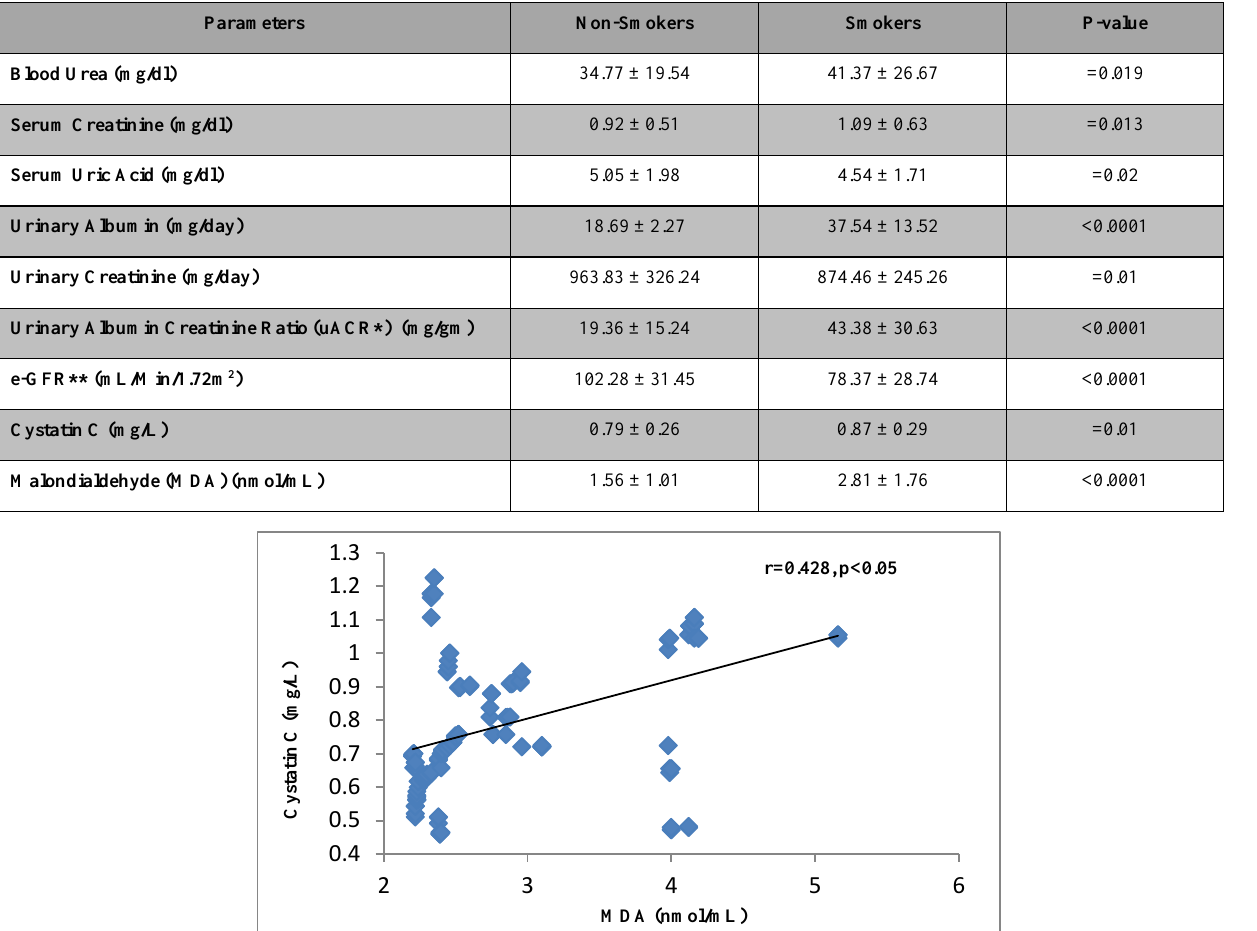
Table:1 Showed biochemical parameters of studied